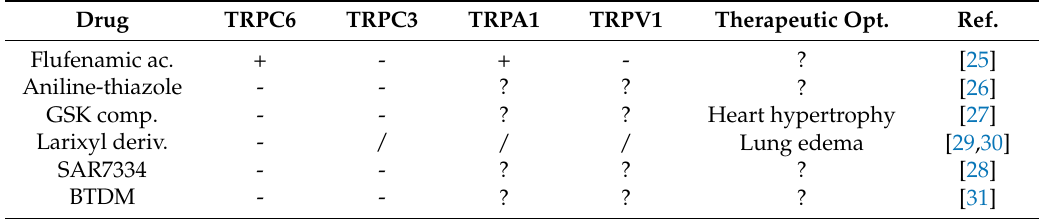
Table 1. Compounds regulating TRPC6 activity and prospective therapeutic options. Drug TRPC6 TRPC3 TRPA1 TRPV1 Therapeutic Opt. Ref. Flufenamic ac. + - + - ? Aniline-thiazole - - ? GSK comp. - - Larixyl deriv. - / / / Lung edema [29,30] SAR7334 - - BTDM - - ? ?